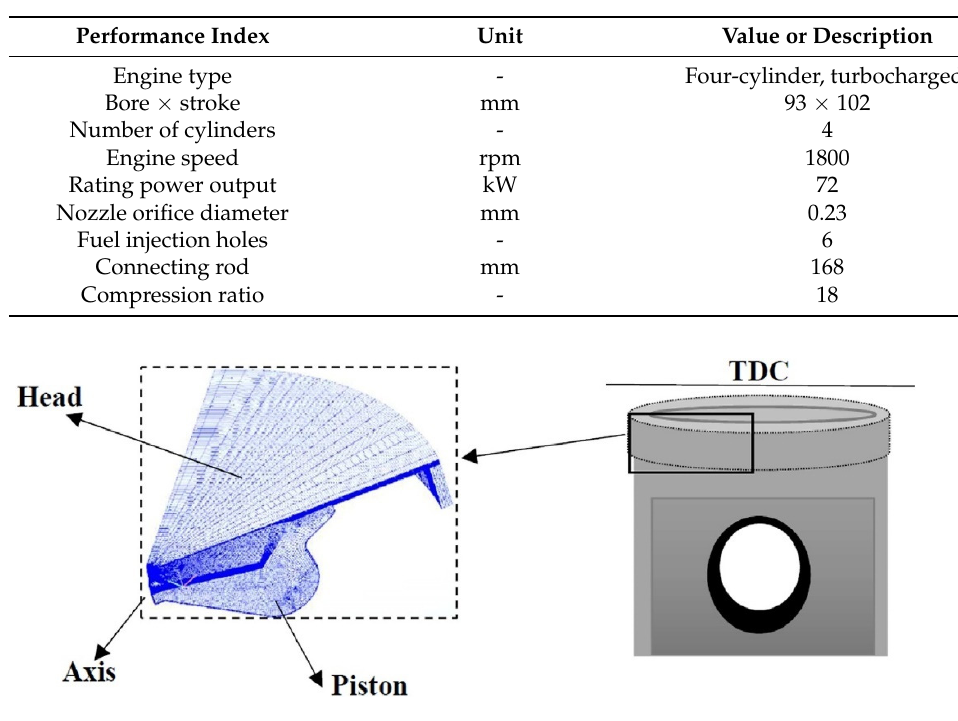
Figure 4. The cylinder pressure comparison of grid independence test.